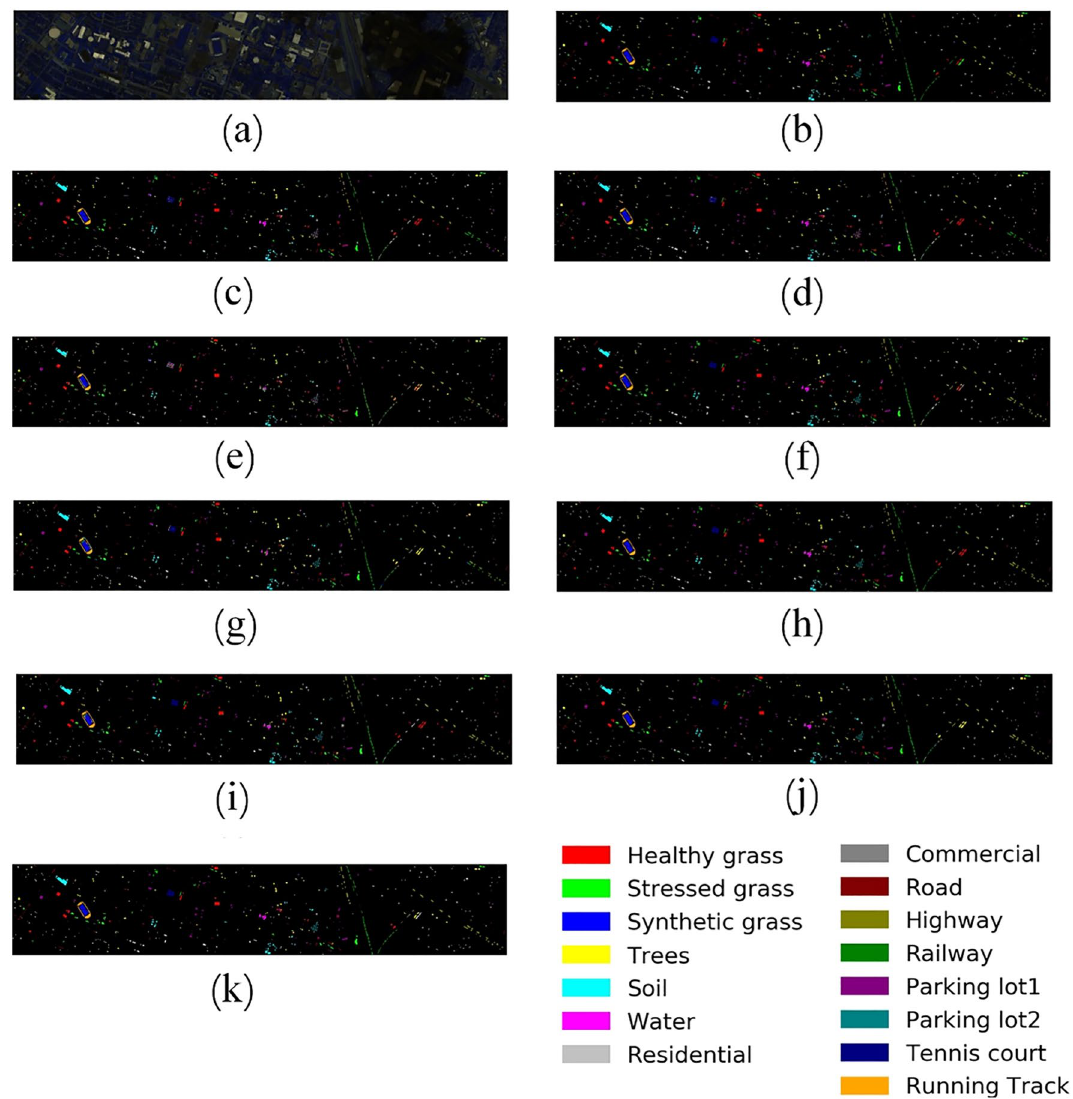
Figure 15. Classification maps of different models on the HU dataset. ( a ) False-color image. ( b ) Ground-truth map. ( c ) MLP. ( d ) 1D-CNN. ( e ) M3D-DCNN. ( f ) SSRN. ( g ) pResNet. ( h ) DBDA. ( i ) SCFR. ( j ) DPSCN. ( k )